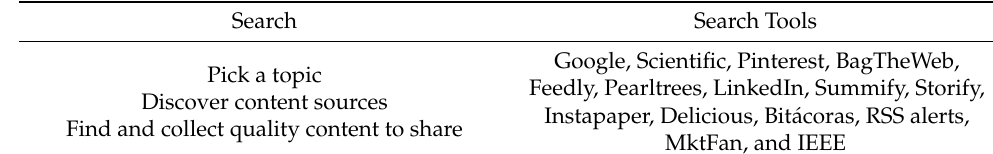
Table 1. Objectives of the content curation steps and